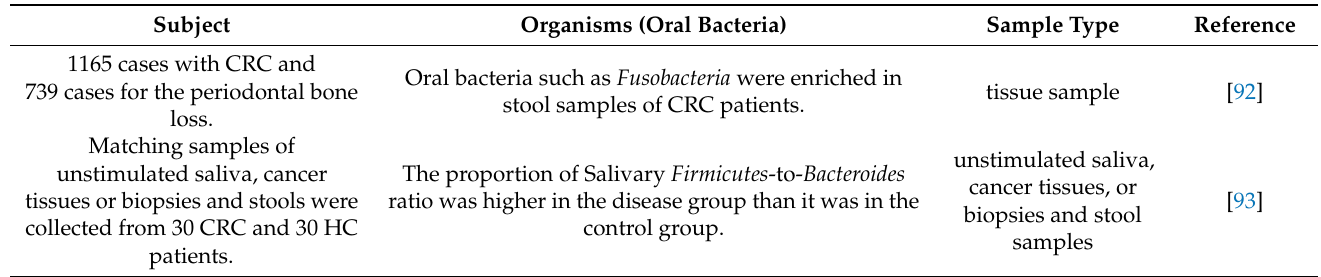
Table 3. Oral organisms associated with colorectal cancer